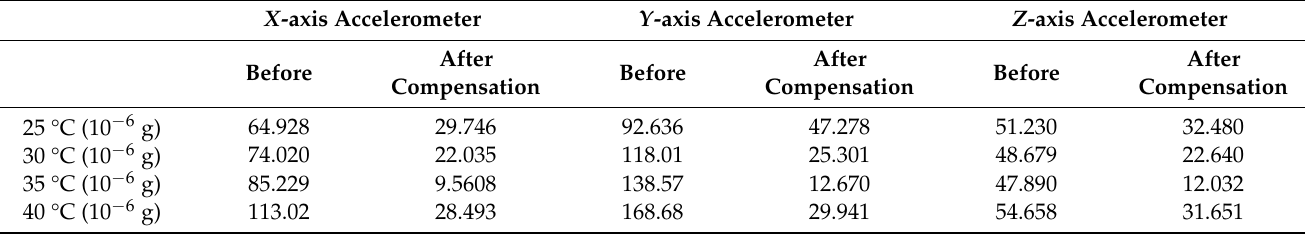
Table 2. Stability of accelerometer in cold start-up stage at different temperature points for three- axis accelerometer. X -axis Accelerometer Y -axis Accelerometer Z -axis Accelerometer